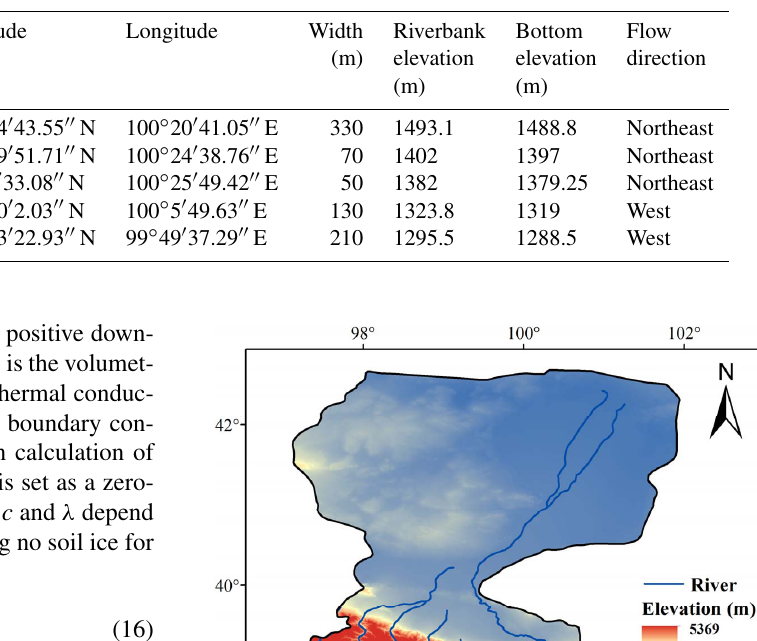
Table 1. The locations and relevant information about the five selected sections used in simulations.